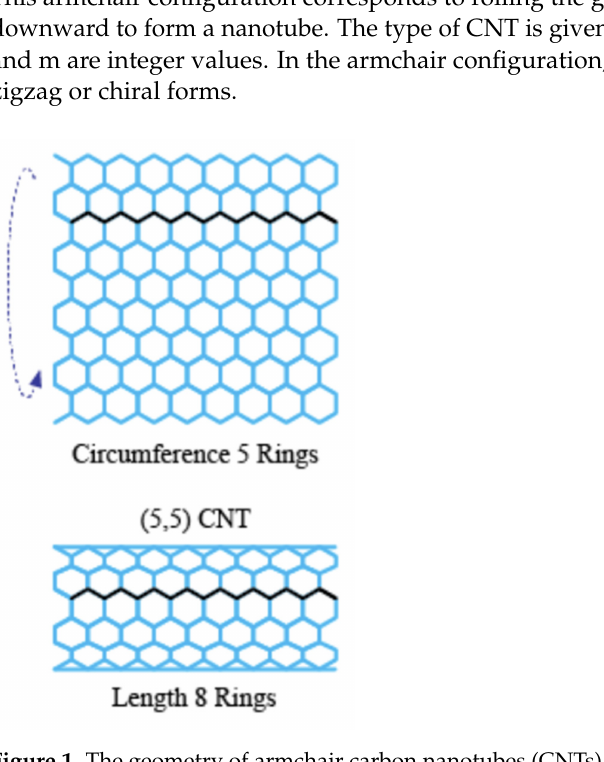
Figure 1. The geometry of armchair carbon nanotubes (CNTs) may be understood by considering a single layer of graphene rolled top to bottom so that the top benzene rings are bonded to the bottom ones to create a tube. In this example of a resultant (5,5) CNT, the circumference may be specified by following a circle around the tube and observing 5 benzene rings. The length in this specific example is 8 benzene rings along the axis. In this work, the modeling is limited to armchair CNTs, where circumference and length may easily be specified by C r and Z r parameters as, for example, C r = 5 and Z r =